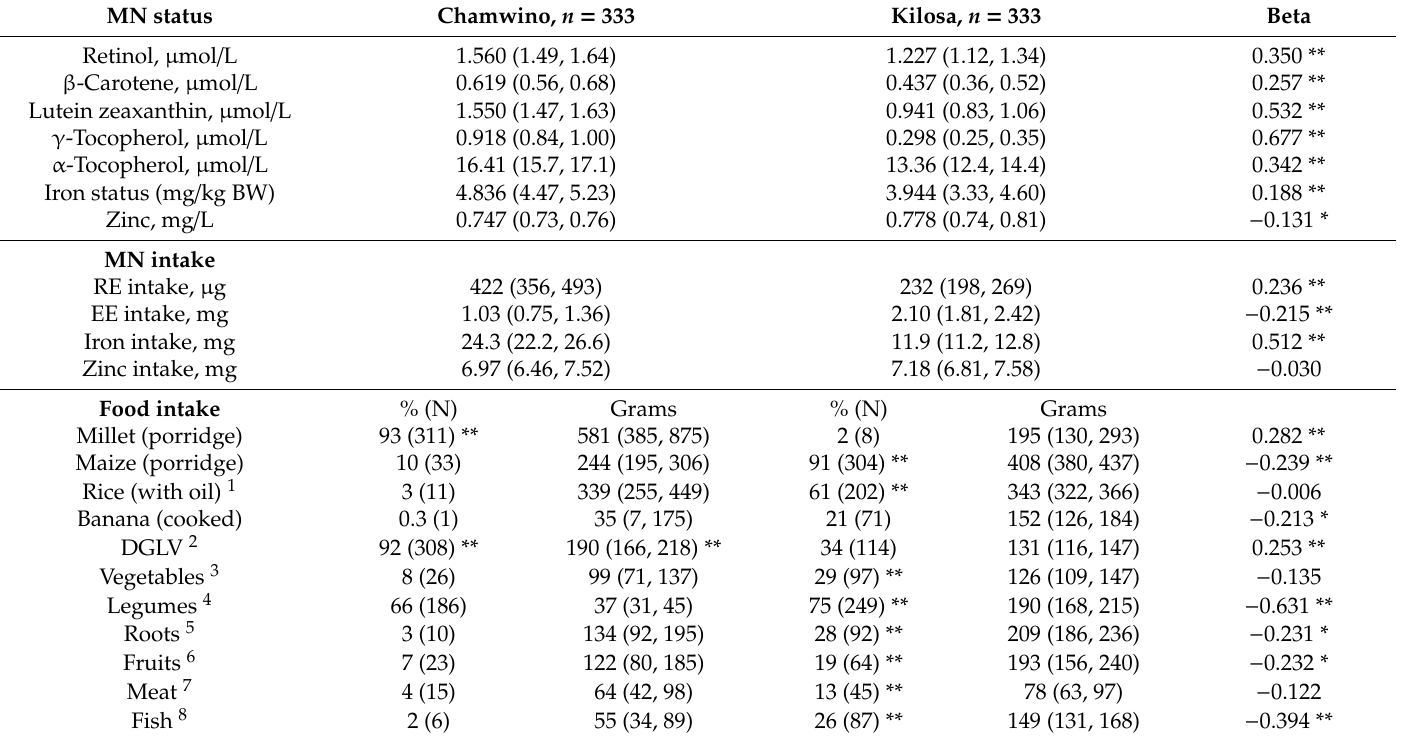
Table 4. Micronutrient status and micronutrient and food intake in women of Chamwino vs. Kilosa